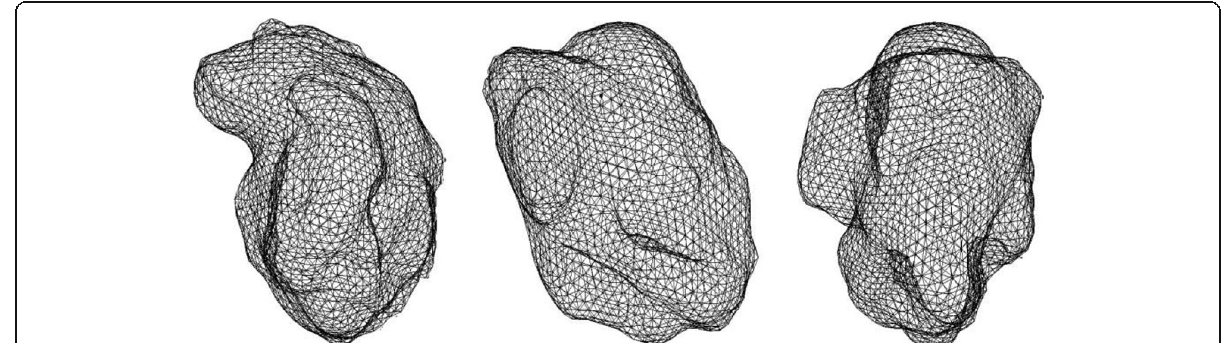
Fig. 7 Schematic diagram of triangulation of the hematoma in STL format